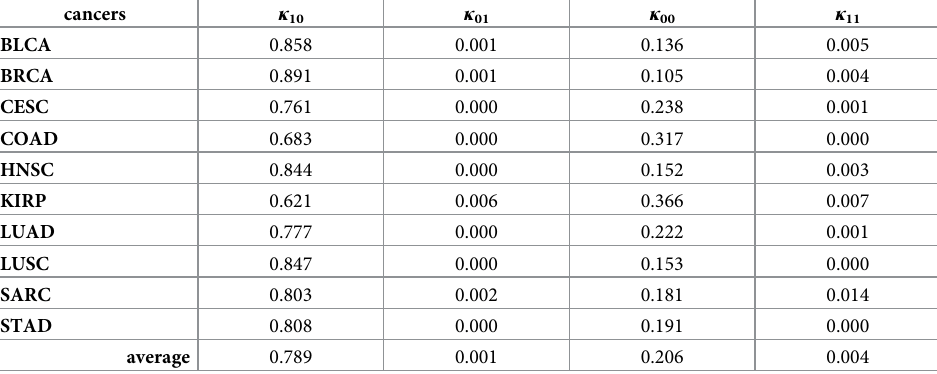
Table 3. Estimated proportion parameters in the three-component mixture null distribution for 10 TCGA